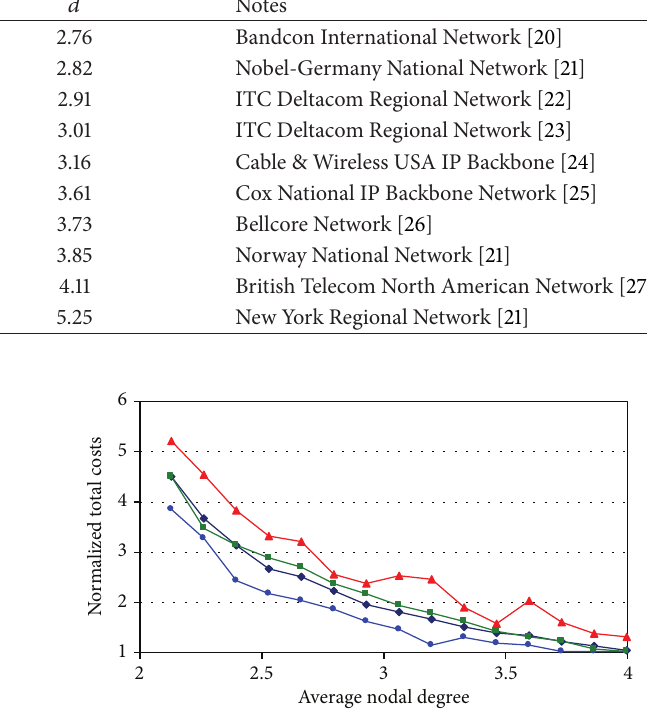
Figure 4: Normalized span restoration JCA total capacity costs.